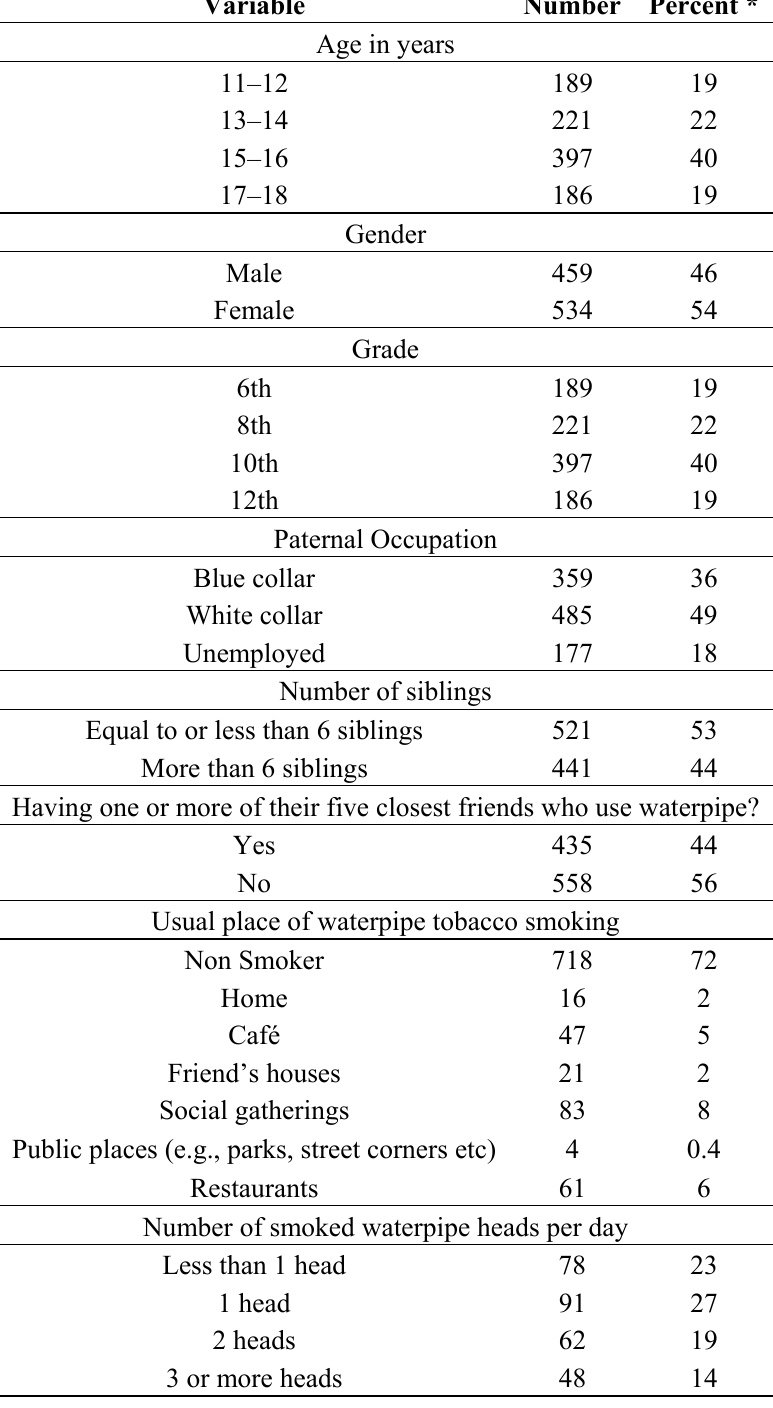
Table 1. Sample demographic characteristics (n =